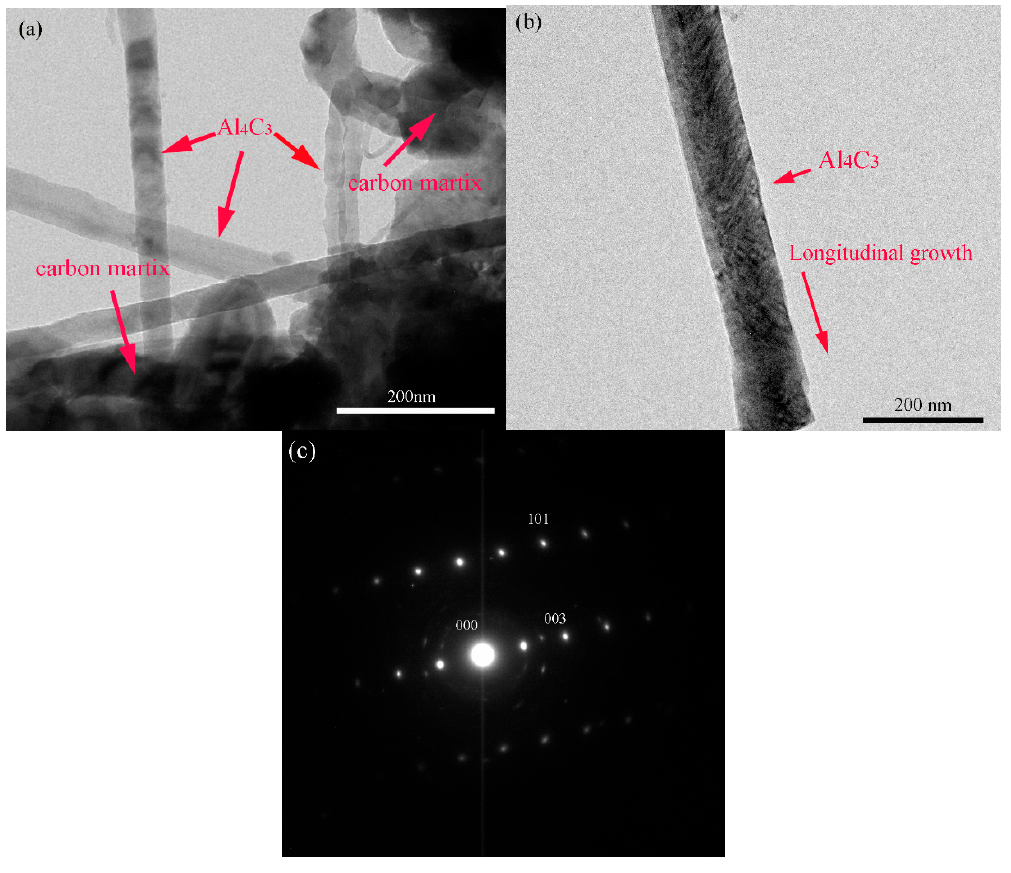
Figure 12. TEM observation of Al 4 C 3 . ( a ) Interface with the reactant of Al 4 C 3 ; ( b ) Al 4 C 3 ; ( c ) SAED (selected area electron diffraction) pattern of Al 4 C 3.